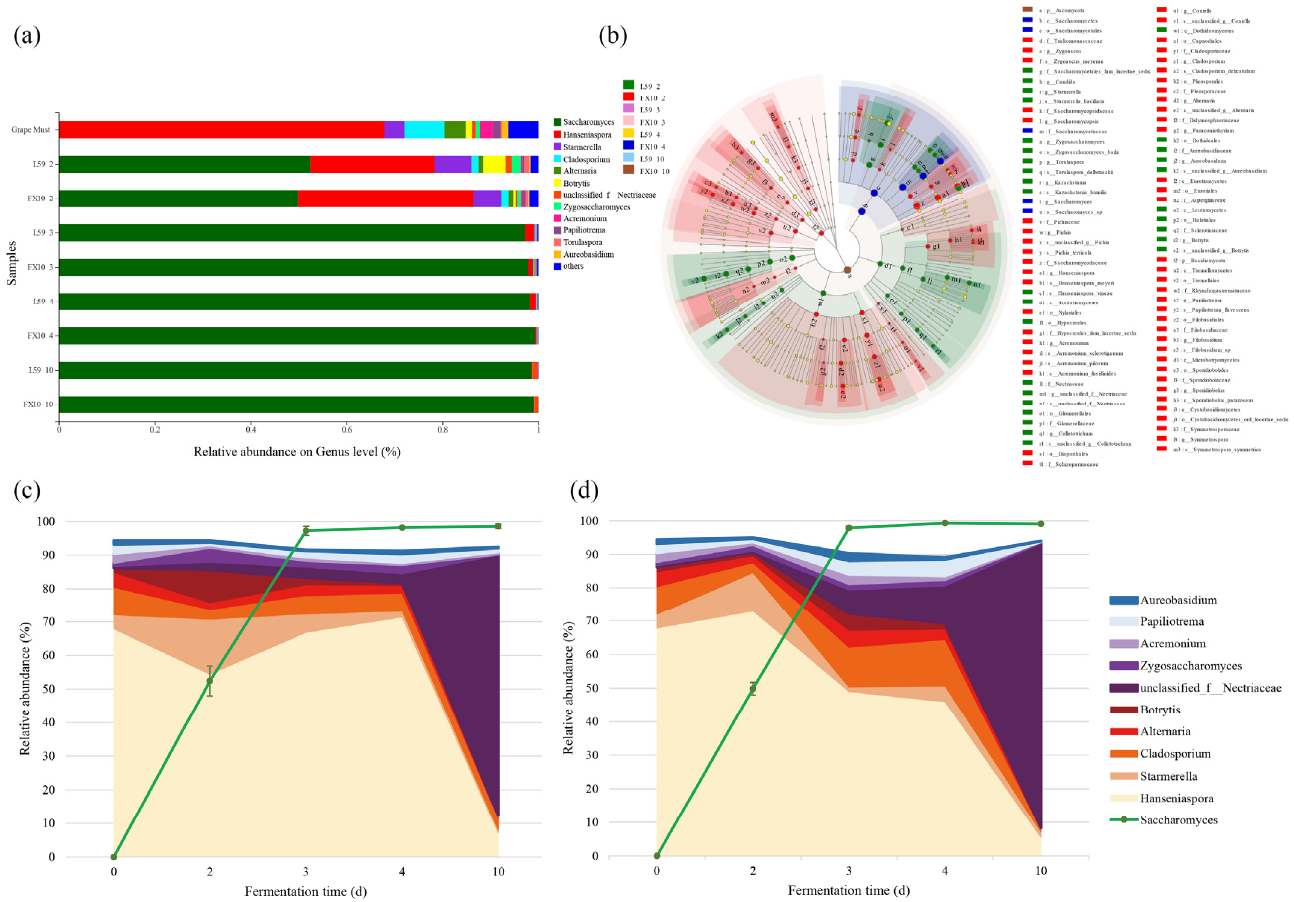
Figure 5. Changes in fungal community composition during the Prince wine fermentation. ( a ) Relative abundance of fungi at the genus level in samples at different fermentation times. ( b ) Linear discriminant analysis with effect size (LEfSe) analysis of microbial relative abundance data during fermentation (LDA > 3, p < 0.05). Changes in the relative abundance of fungal communities in fermentation samples inoculated with strain L59 ( c ) and yeast FX10 ( d ). Stacked area graphs show the relative abundance composition of the communities except S. cerevisiae .